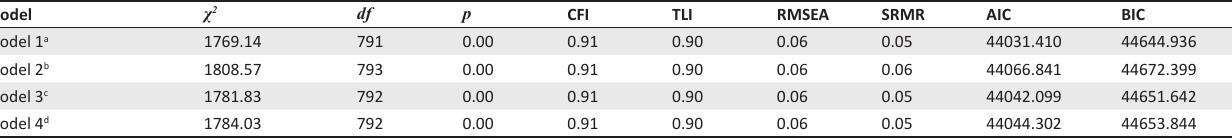
TABLE 4 : Results for the structural model.